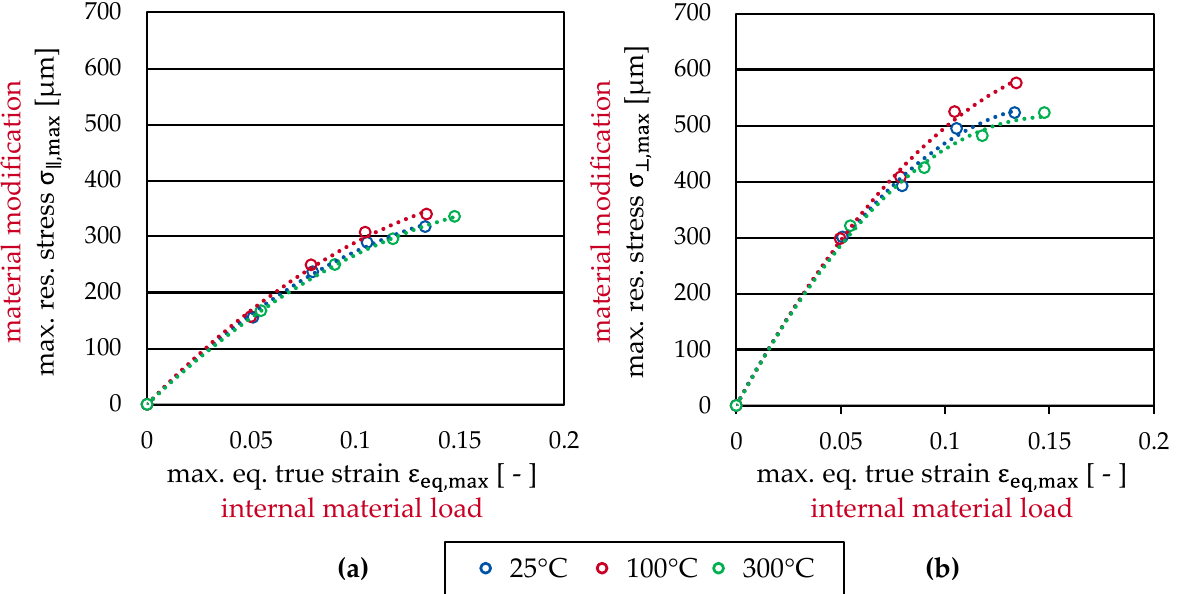
Figure 16. Simulated Process Signature Components for deep rolling describing the changes of maximal residual stress components in dependence of the maximal equivalent strain at different workpiece temperatures ( a ) for the maximum residual stress parallel to the rolling direction, and ( b ) for the maximum residual stress perpendicular to the rolling direction. All values derived from simulations.